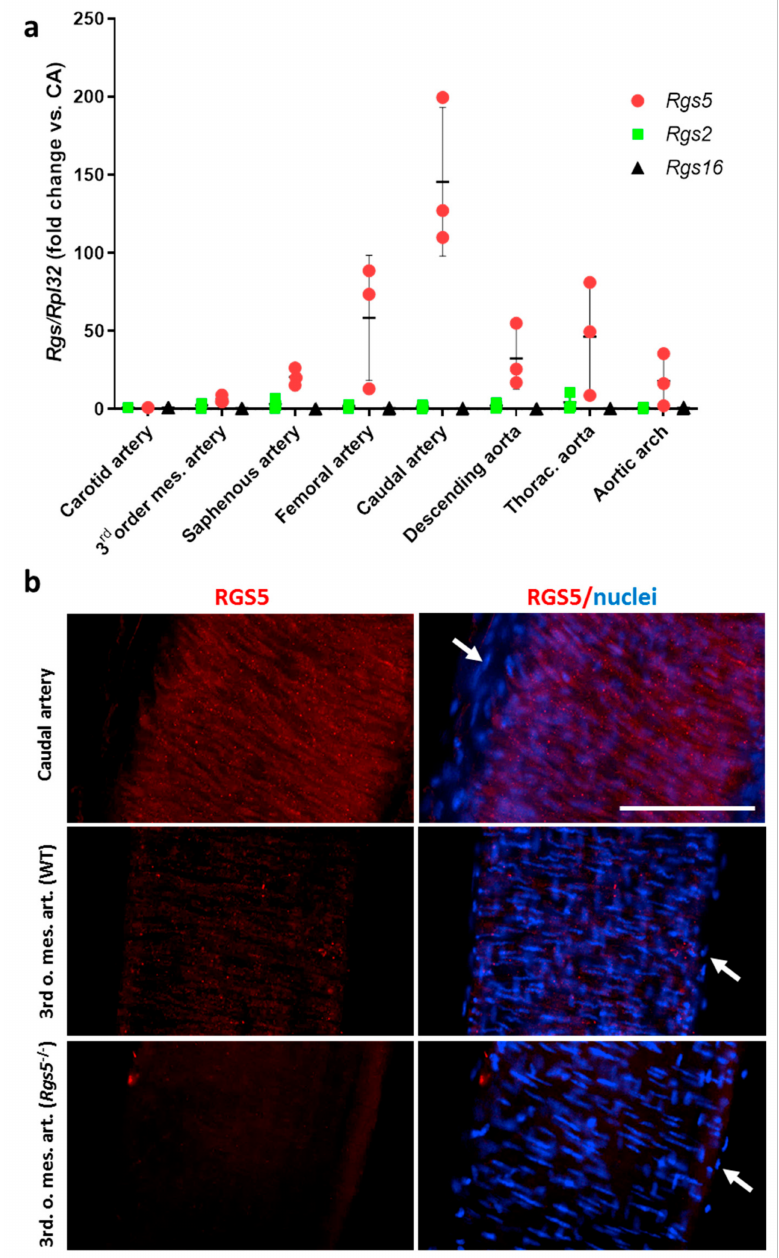
Figure 1. Analysis of the Rgs5 expression in different types of mouse arteries. ( a ) qPCR analyses were performed to determine the relative expression levels of Rgs5, Rgs2, and Rgs16 in different arteries of adult C57 BL/6 mice as compared to the carotid artery as a reference (set to 1). Expression of the housekeeping gene Rpl32 was used as internal reference (n = 3). Note that the overall expression levels of Rgs2 and Rgs16 are much lower as compared to Rgs5 . ( b ) RGS5 was detected by whole mount immunofluorescence-based techniques (red fluorescence) in the caudal artery (upper panel) and 3rd order branches of the mesenteric artery of WT and Rgs5 − / − mice. The images represent the maximum fluorescence intensity projection of a Z-stack generated by confocal microscopy including all layers of the corresponding arteries. VSMCs can by identified by their circular orientation (scale bar: 100 µ m, arrows point at nuclei located in the adventitial